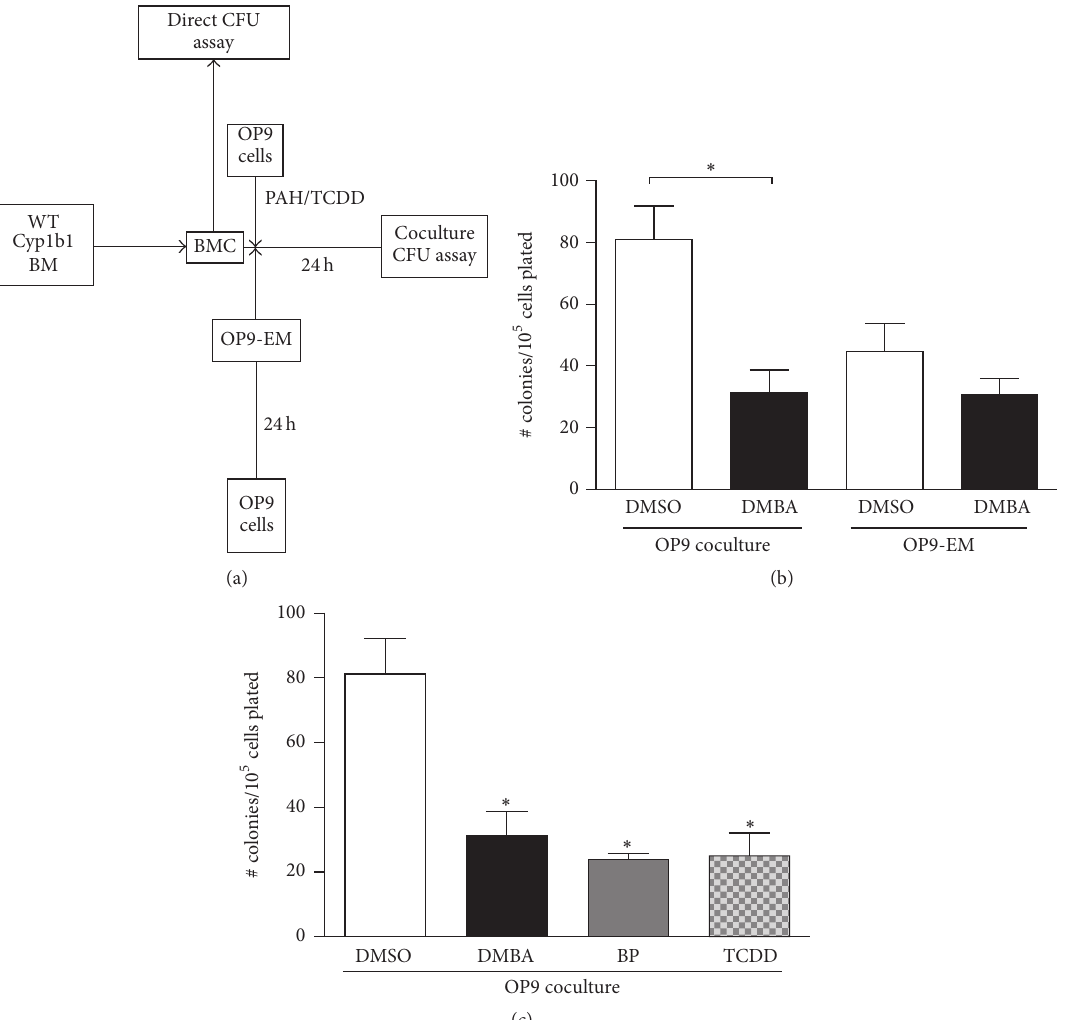
Figure 3: Effect of PAH treatment on WT progenitor activity in OP9 coculture from the fresh BMC preparation without in vitro culture. (a) Experimental design for assessing effects of PAHs on progenitor proliferation (PreB CFU activity) of cultured BMC. Cells isolated from the BM of mice of different genotypes are cocultured with serum media for 24 hours alone, on a monolayer stromal support (OP9 or BMS2 cells) or media enriched by 24-hour culture with OP9 cells (OP9-EM). PAH (1 𝜇 M), TCDD (0.01 𝜇 M), or an equivalent volume of DMSO solvent is added at the beginning of the 24-hour period. BMC (5 × 10 5 cells) are added to the CFU methyl cellulose suspension assay at the end of 24 hours. Direct addition of BMC to the CFU assay provides a 100 percent reference activity. (b) Effect of DMBA (1 𝜇 M) in OP9 coculture compared with effect in enriched medium (OP9-EM). ∗ Statistical significance; 𝑝 value < 0.05. (c) OP9 coculture experiments with DMBA (1 𝜇 M), BP (1 𝜇 M), and TCDD (0.01 𝜇 M) treatments showed significant ( ∗ 𝑝 < 0.05 ) loss of activity after 24-hour treatment, as compared with the DMSO solvent